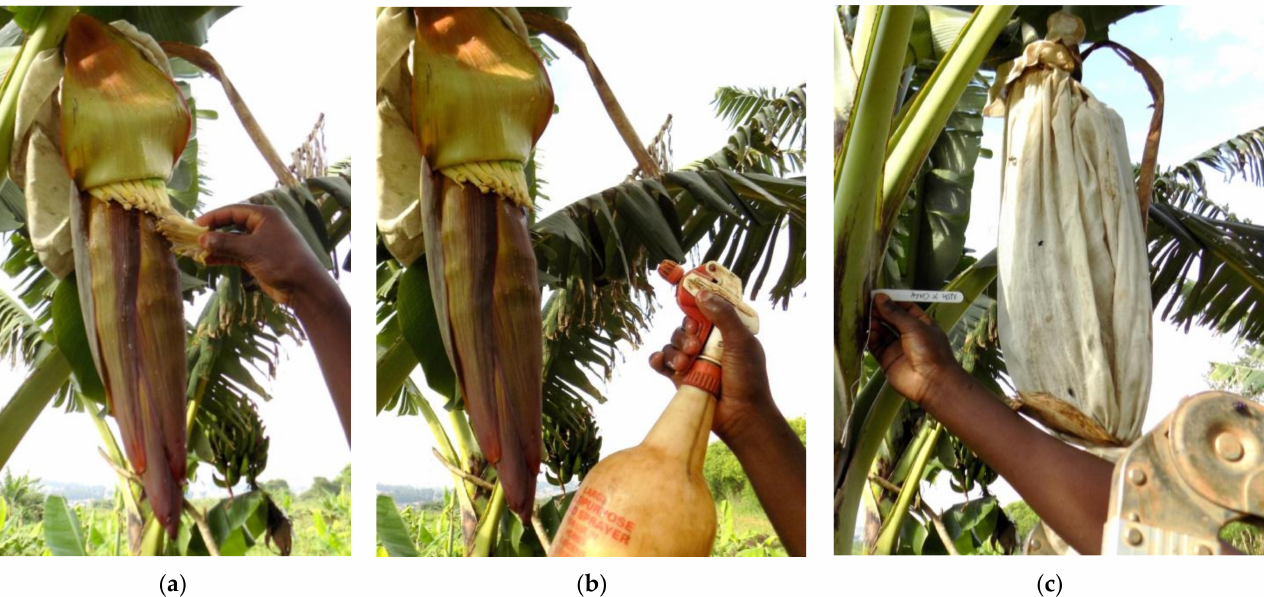
Figure 1. Procedure of pollination with pollen germination media to enhance stigma receptivity on Musa (AA group subgroup Mchare) ‘Nshonowa’: ( a ) male flowers rubbed on stigmas of the first hand to apply pollen; ( b ) spraying of pollen germination medium (PGM); ( c ) inflorescence re-bagged and